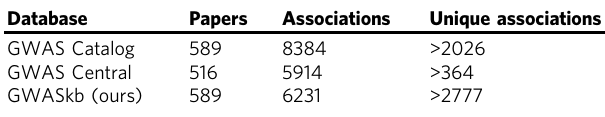
Table 1 Numbers of associations contained in different GWAS databases; statistics are over open-access